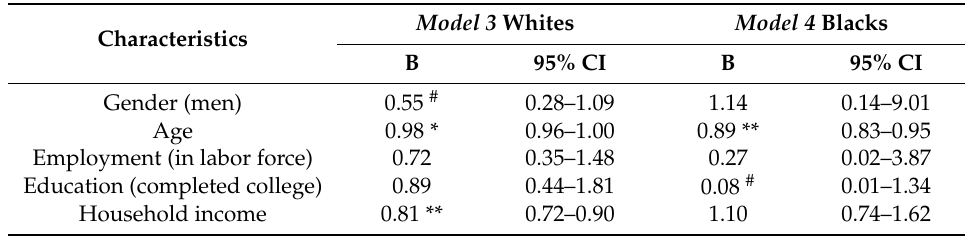
Table 4. Summary of logistic regressions between household income and poor SRMH in Whites and Blacks.